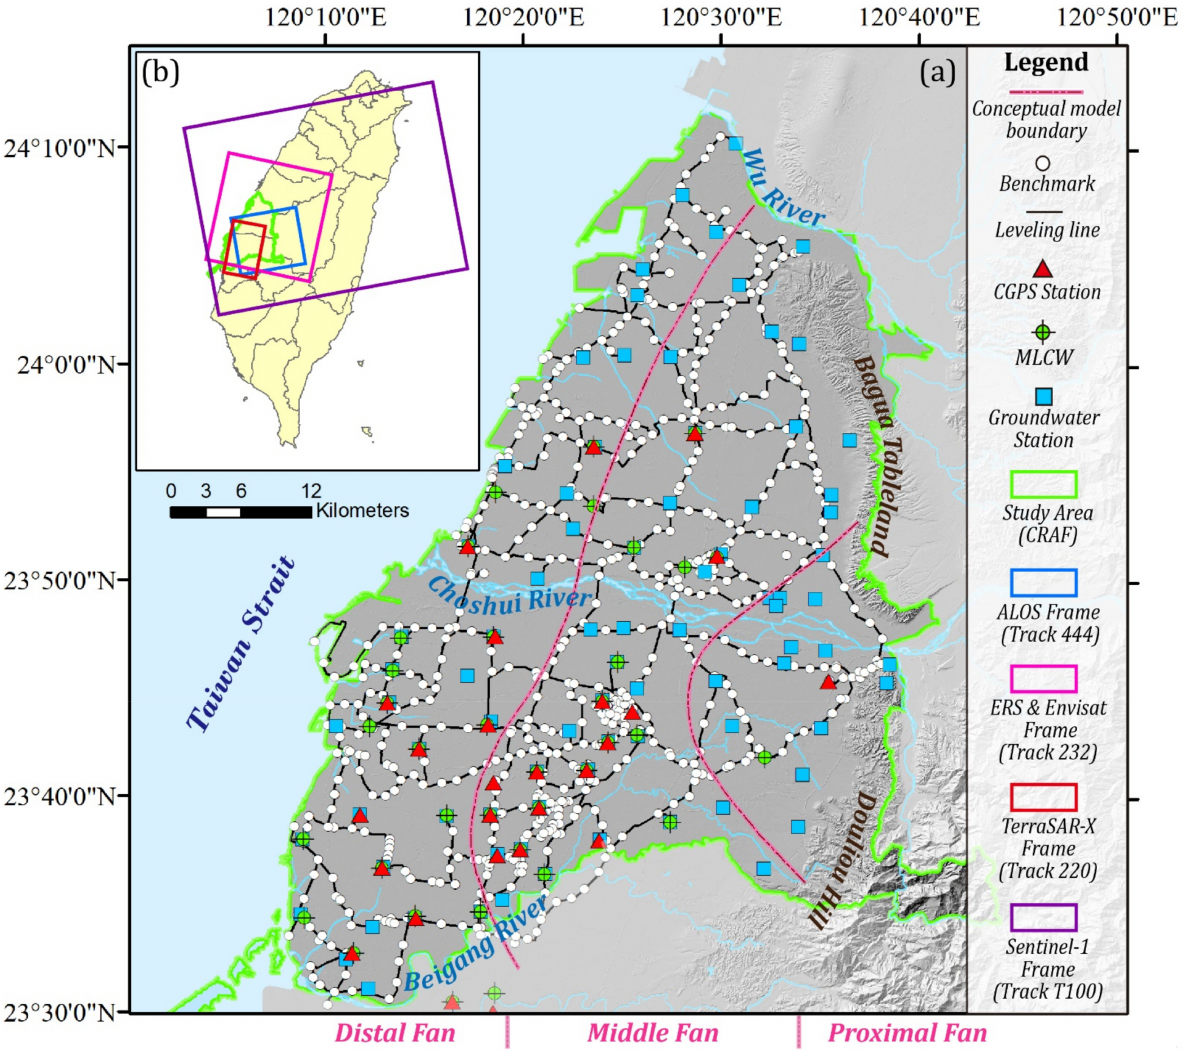
Figure 1. ( a ) The geographical location of the CRAF and the distribution of the monitoring instruments. White dots, green circles, red triangles, and blue rectangles represent the distributions of leveling benchmarks, CGPS stations, MLCWs, and GWs, respectively. The black lines around the CRAF represent the leveling network used to survey land subsidence. ( b ) Ground tracks of SAR data acquired by ALOS, ERS-1/2, Envisat, TerraSAR-X, and Sentinel-1 in the CRAF area. The blue, pink, red, and purple boxes indicate the footprints of ALOS, ERS, Envisat, TerraSAR-X, and Sentinel-1 images,